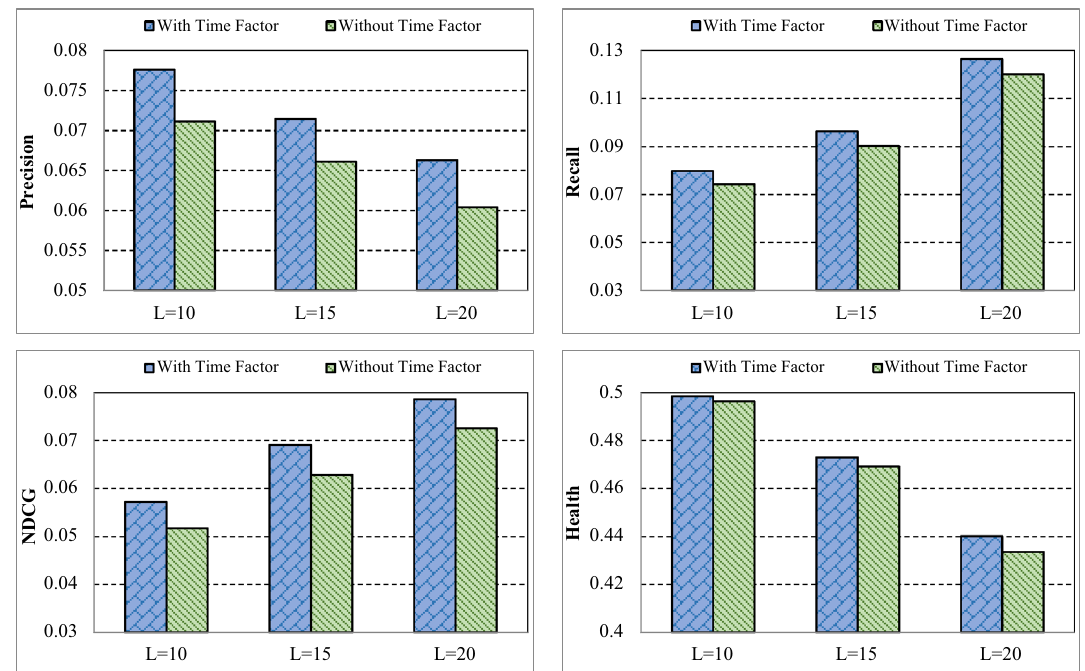
Fig. 7 The comparison of the proposed FRSHR method with the model obtained by ignoring the time